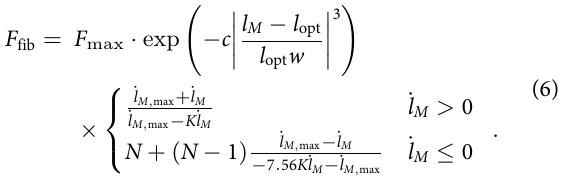
The first term q ( t ) represents the muscle activity. The